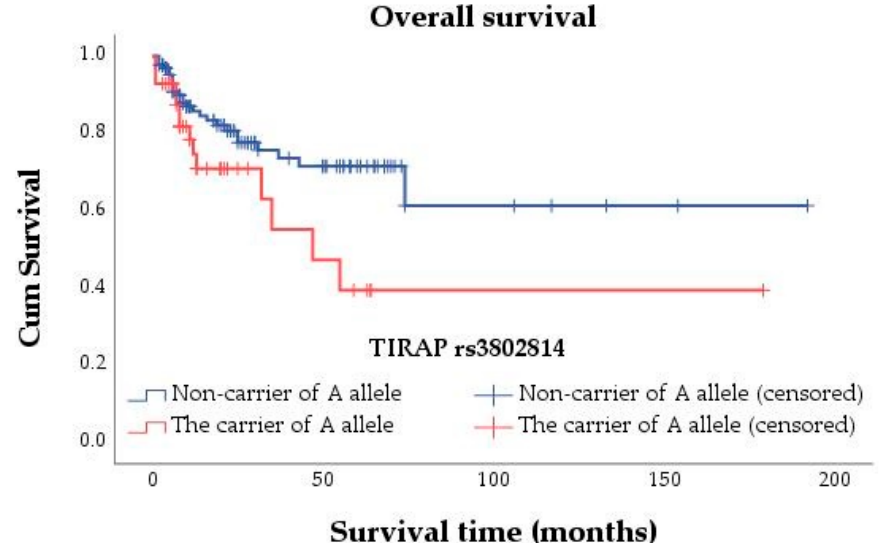
Figure 1. Kaplan–Meier survival curve for the association between the A allele of rs3802814 and OS.